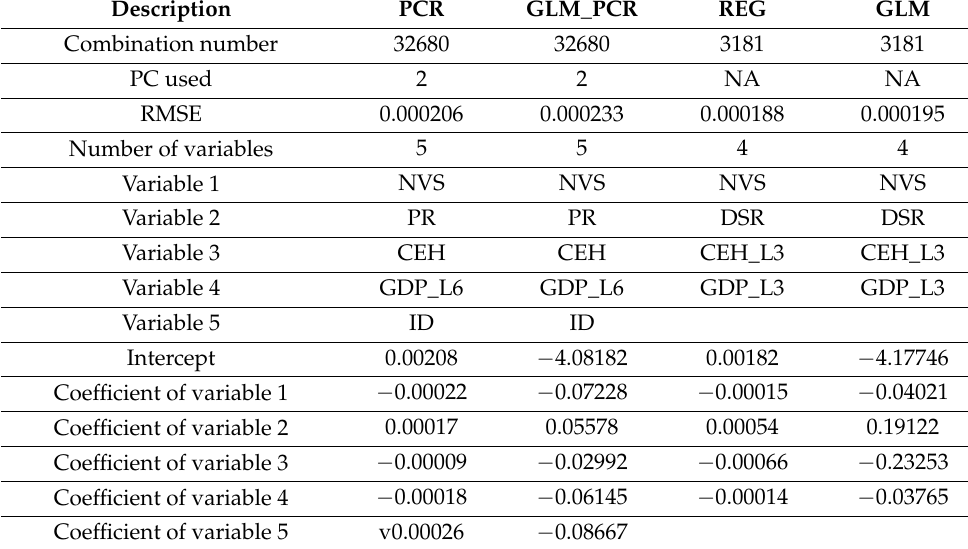
Table 6. Best model for PCR, GLM-PCR, REG and